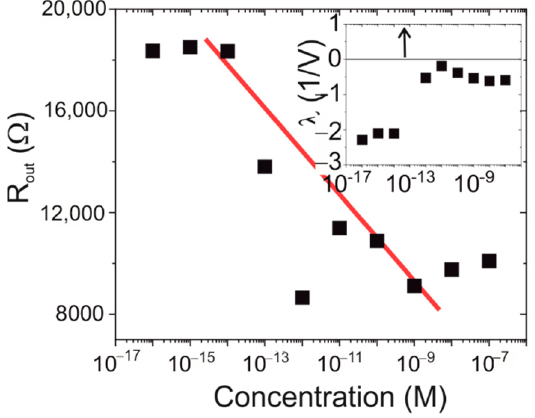
Figure 7. The output resistance as a function of the spike protein concentration. The red line indicates the trend line. The inset shows the lambda parameter which is related to the channel shortening. The arrow at 100 fM indicates an omitted point at λ = 33.4 V − 1 .